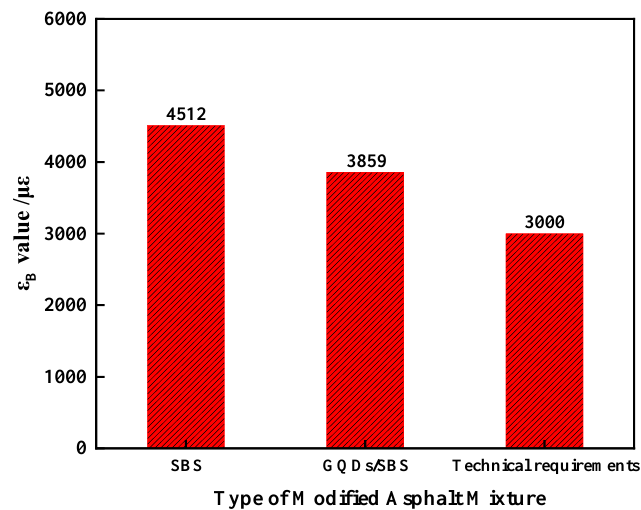
Figure 16. Results of beam bending test.